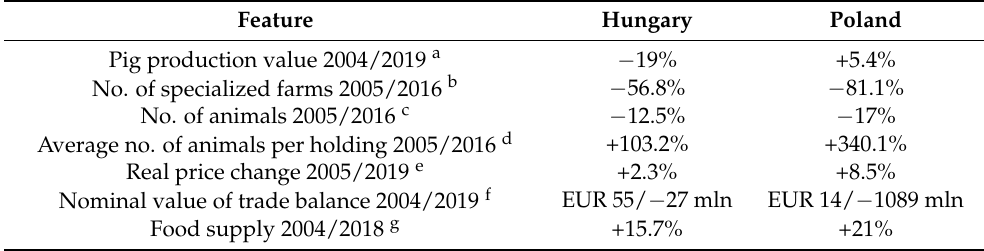
Table 1. Changes in pork-producing farms and their environment in Poland and Hungary after 2004. Feature Pig production value 2004/2019 a − 19% +5.4% No. of specialized farms 2005/2016 b − 56.8% − 81.1% No. of animals 2005/2016 c − 12.5% − 17% Average no. of animals per holding 2005/2016 d +103.2% +340.1% Real price change 2005/2019 e +2.3%